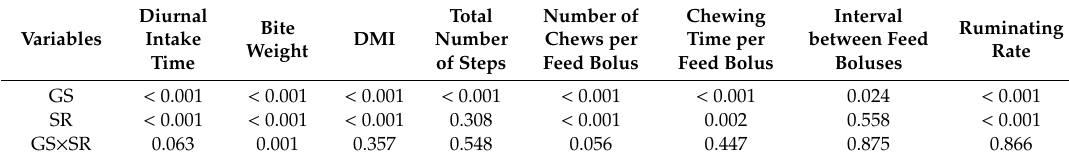
Table 3. The p –values of the e ff ects of grazing season, stocking rate, and their interactions on grazing behavior of Tibetan sheep.